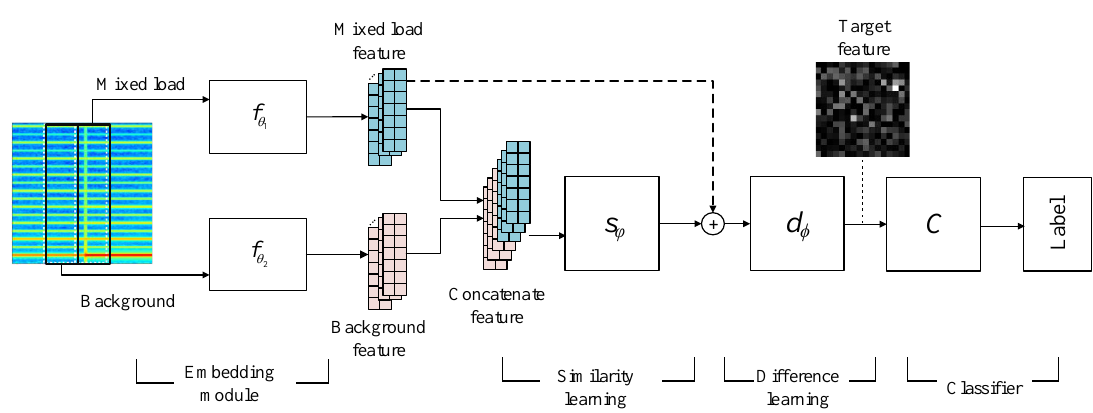
Figure 4. The structure of concatenate convolutional neural networks (CNNs). The concatenation operation is